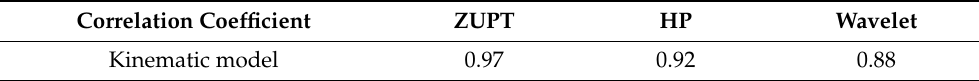
Table 2. Mean and standard deviation of error after different drifts correction methods.